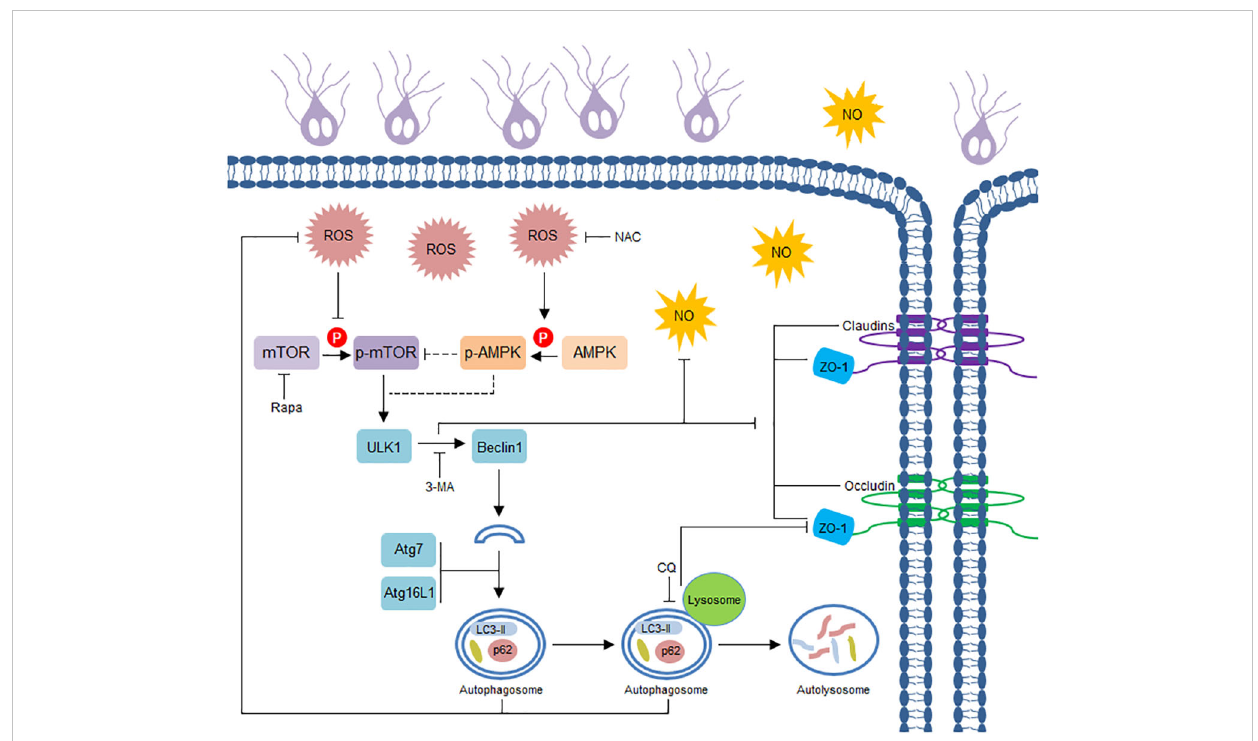
FIGURE 5 Schematic diagram illustrating Giardia -induced IEC autophagy pathway and its role in TJ/NO